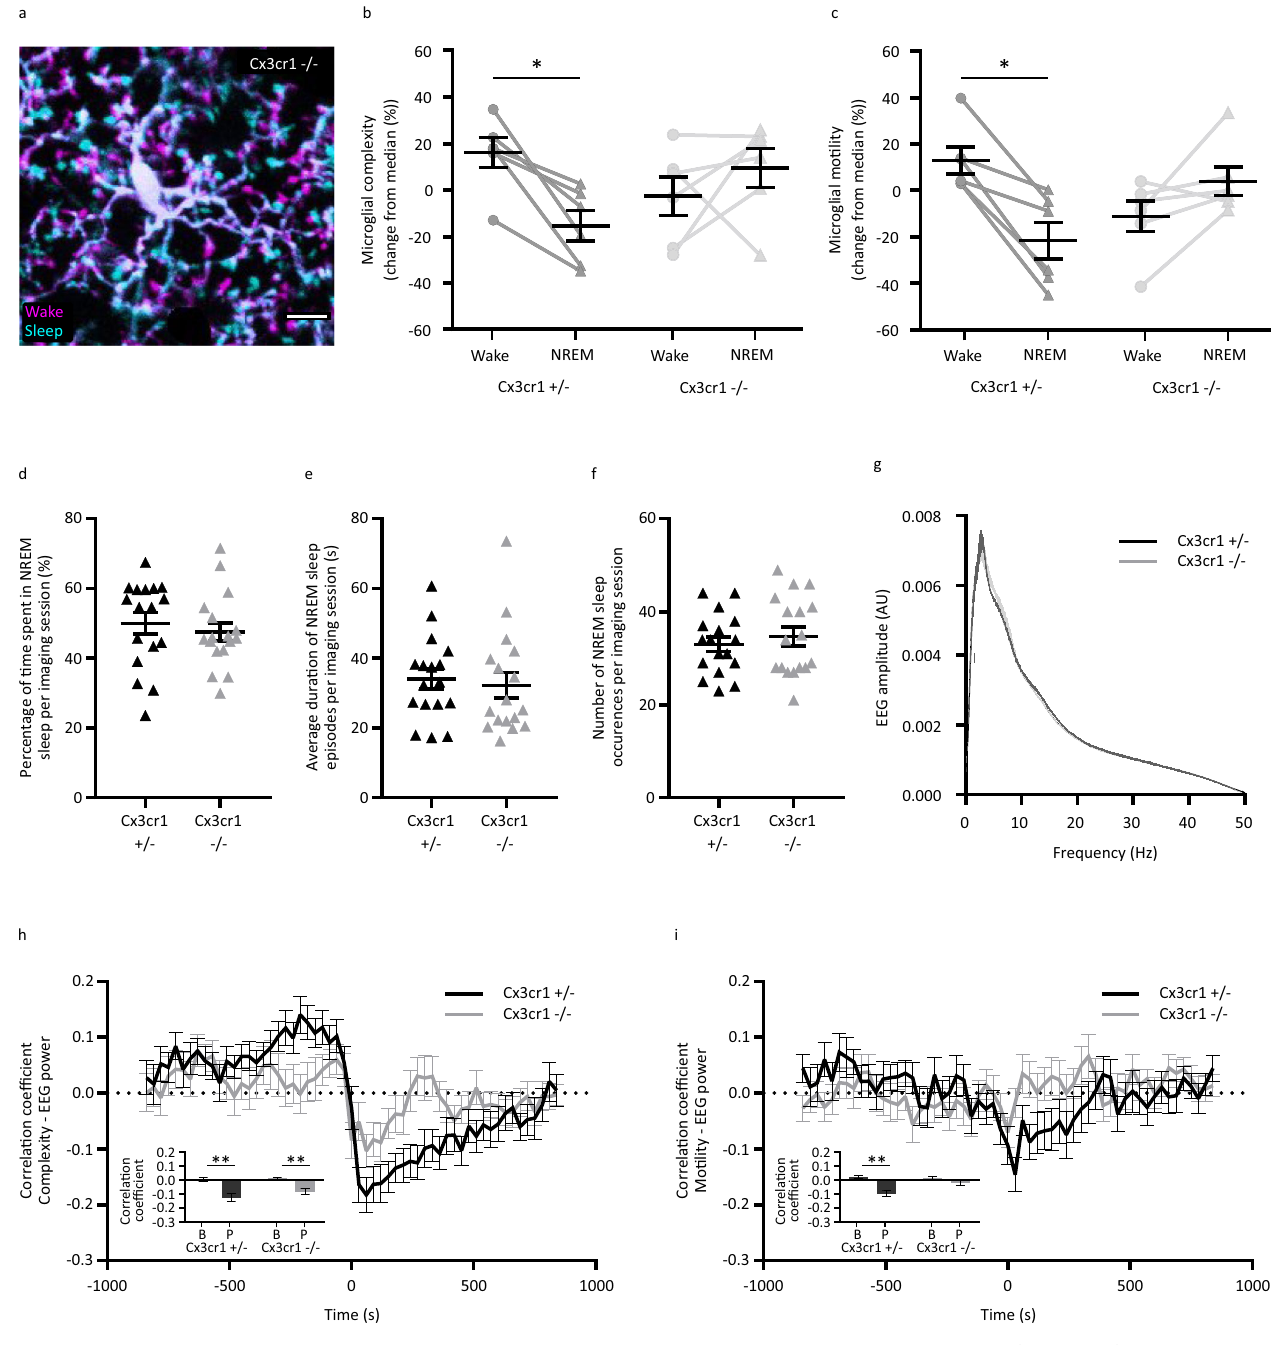
( n =17 sessions from six mice for both Cx3cr1 +/- and Cx3cr1 -/- mice, Mann-Whitney test,two-tailed, p =0.3891,p=0.4482and p =0.6762respectively). g Comparisonof EEGamplitude-frequencyplotof Cx3cr1 +/- (black, n =6mice)and Cx3cr1 -/- (gray, n =4 mice)mice.Cross-correlationanalysisbetween h averagemicroglialcomplexityand i averagemicroglialmotilitywith regards to the average EEG power ( n =20cells for Cx3cr1 +/- and n =22 cells for Cx3cr1 -/- respectively, Wilcoxon test, two-tailed, ** p =0.0023 and ** p =0.0042 for complexity and ** p =0.0032 and p =0.4060 for motility, for Cx3cr1 +/- and Cx3cr1 -/- respectively). All data are represented as mean± SEM. Source data are provided as a Source Data fi le for b – i